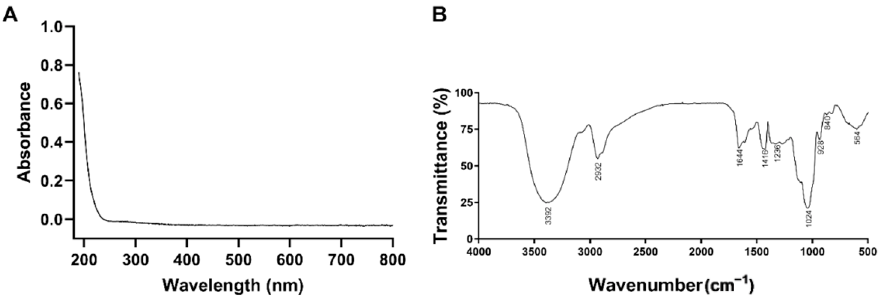
Figure 3. UV-Vis and FT-IR spectrums of As sP. ( A )The UV-Vis spectrum of an As sP water solution from 190–800 nm. ( B ) The transmittance of As sP mixed with KBr on a FT-IR spectrometer of 500- 4000 cm − 1